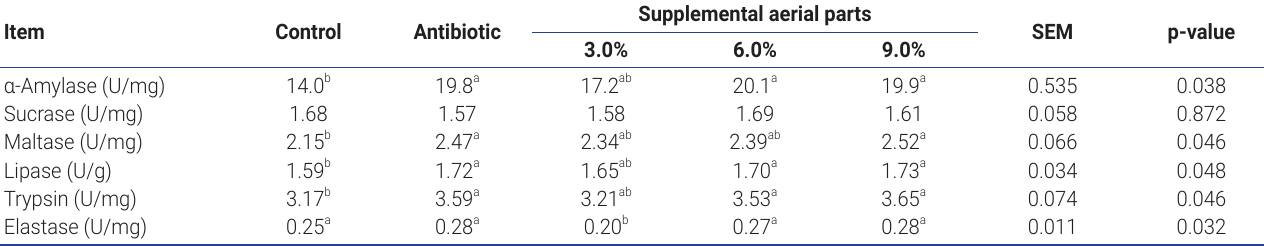
Table 5. Effect of Salvia miltiorrhiza aerial parts on the duodenal digestive enzymes of